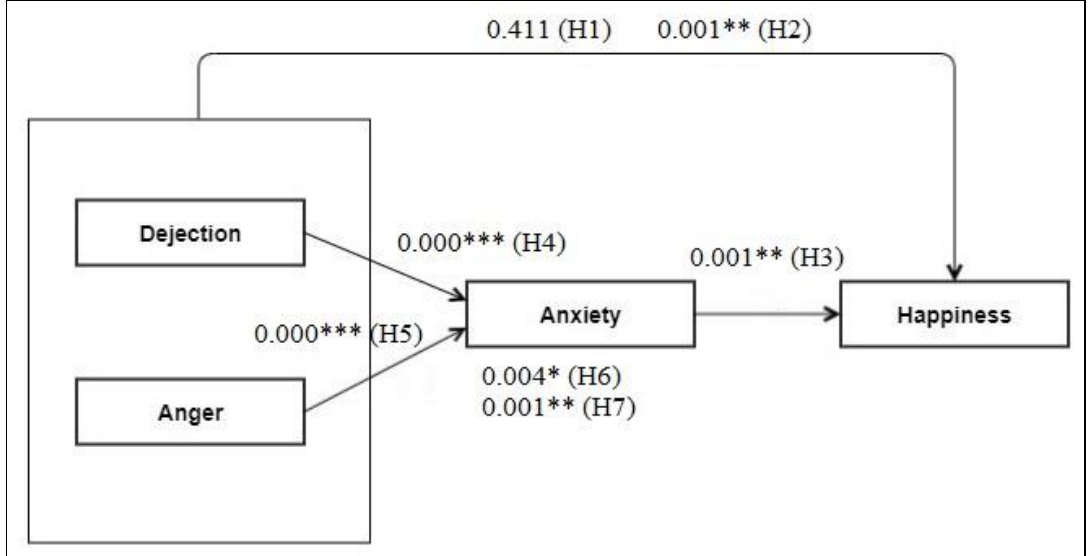
Figure 4. Final work-related affective feelings (WORAF) model ( p -values). Note: * p < 0.05. ** p < 0.01.